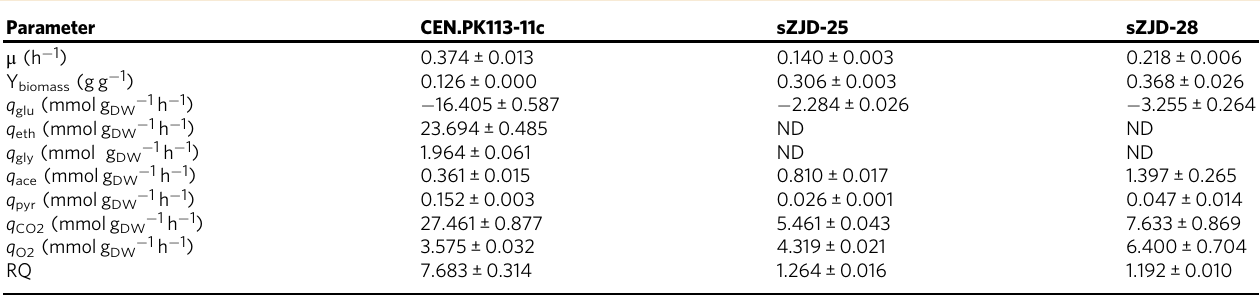
a Data are shown mean values±standard deviations of triplicates ND not